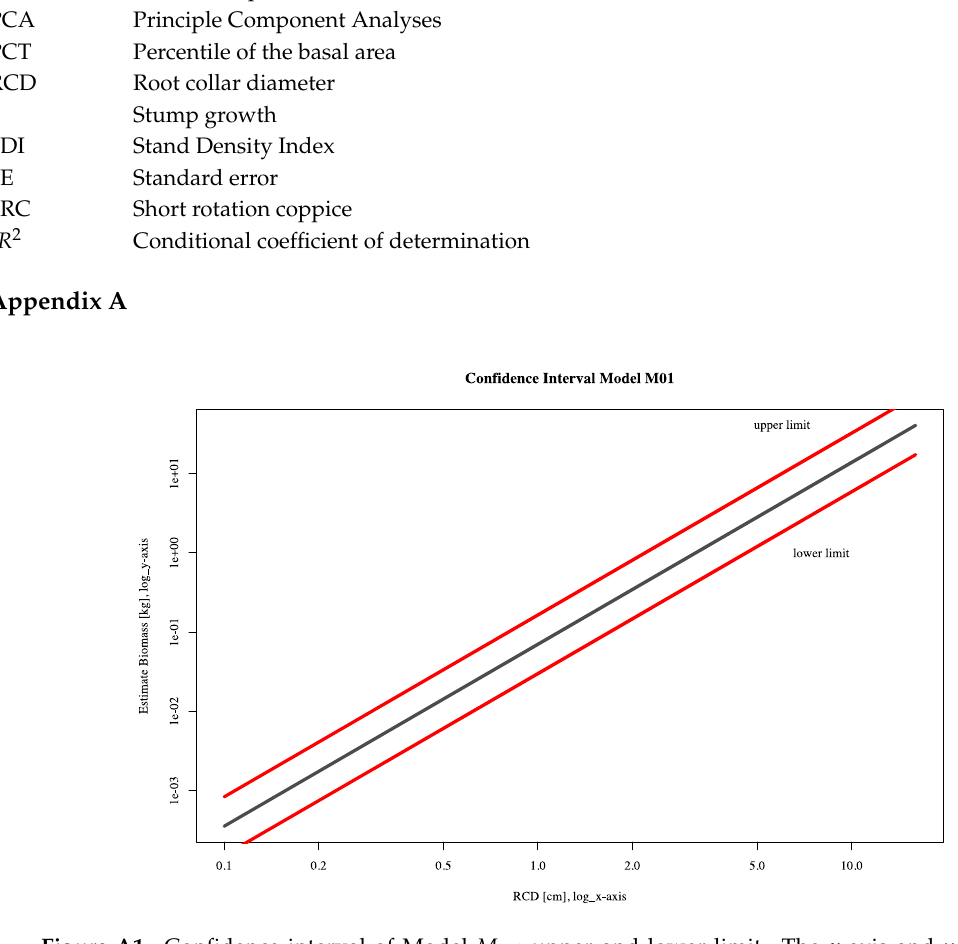
Figure A1. Confidence interval of Model M 01 ; upper and lower limit. The x -axis and y -axis are log transformed. Table A1. Variables, parameters, estimate, standard error (SE), p -value, conditional R 2 ( c R 2 ), AIC, variance, and confidence interval (95%) for (ln) relationship of double-logarithmic of the mixed biomass